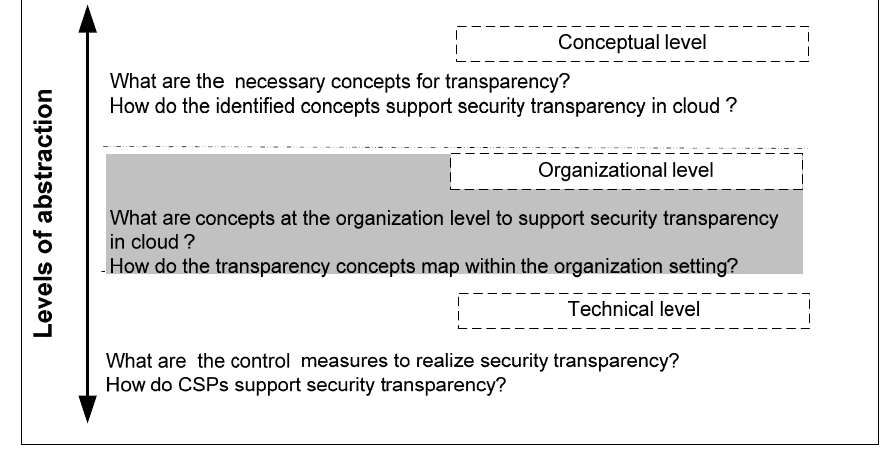
Figure 4. Levels of abstraction for security transparency in cloud.